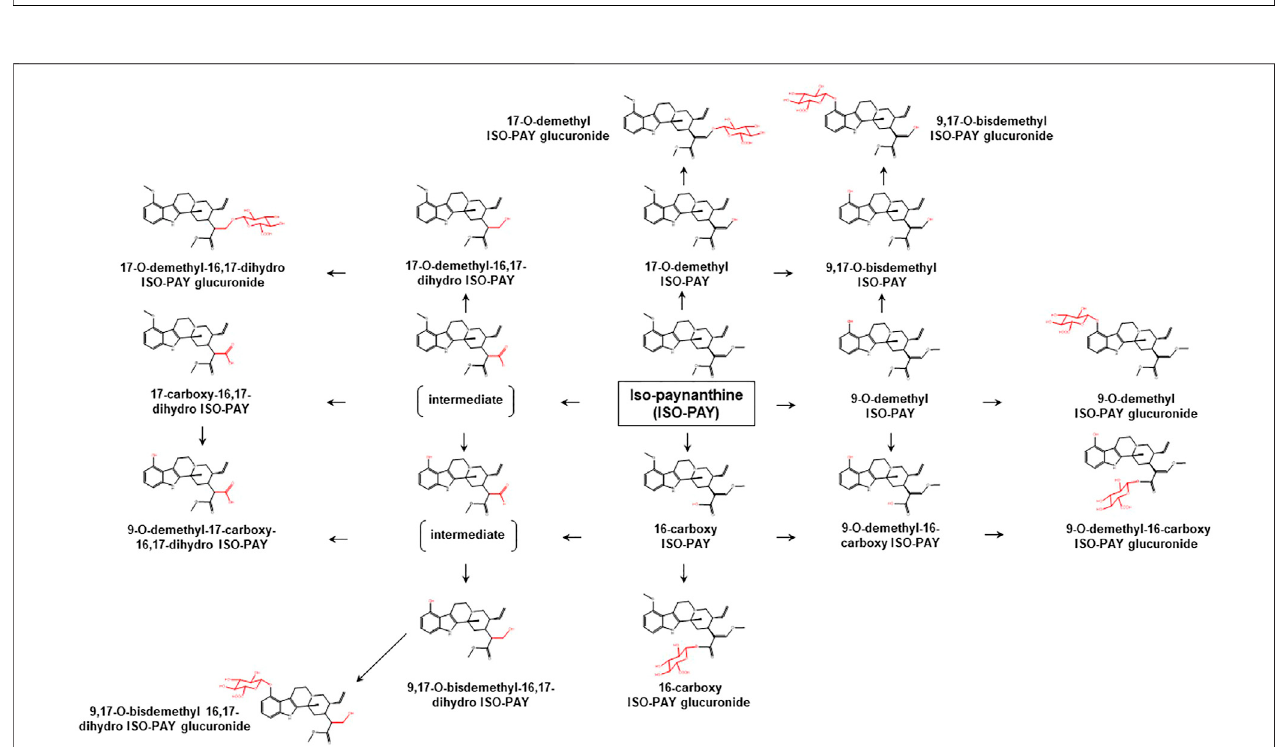
FIGURE 7 | Proposed metabolic pathways of ISO-PAY based on data obtained in rodents and humans. Structures highlighted in red denote structural transformation from parent molecule ISO-PAY. Figure was modi fi ed from Philipp et al. (2011b).